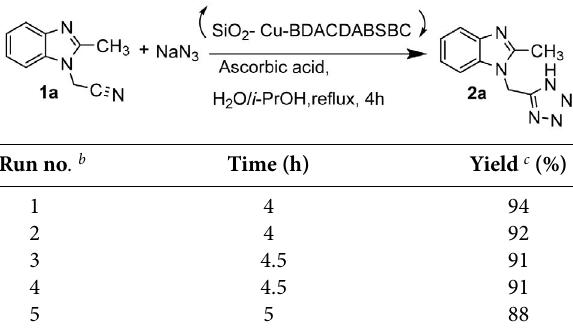
Entry Catalyst Time (h) Yield b (%) Ref.